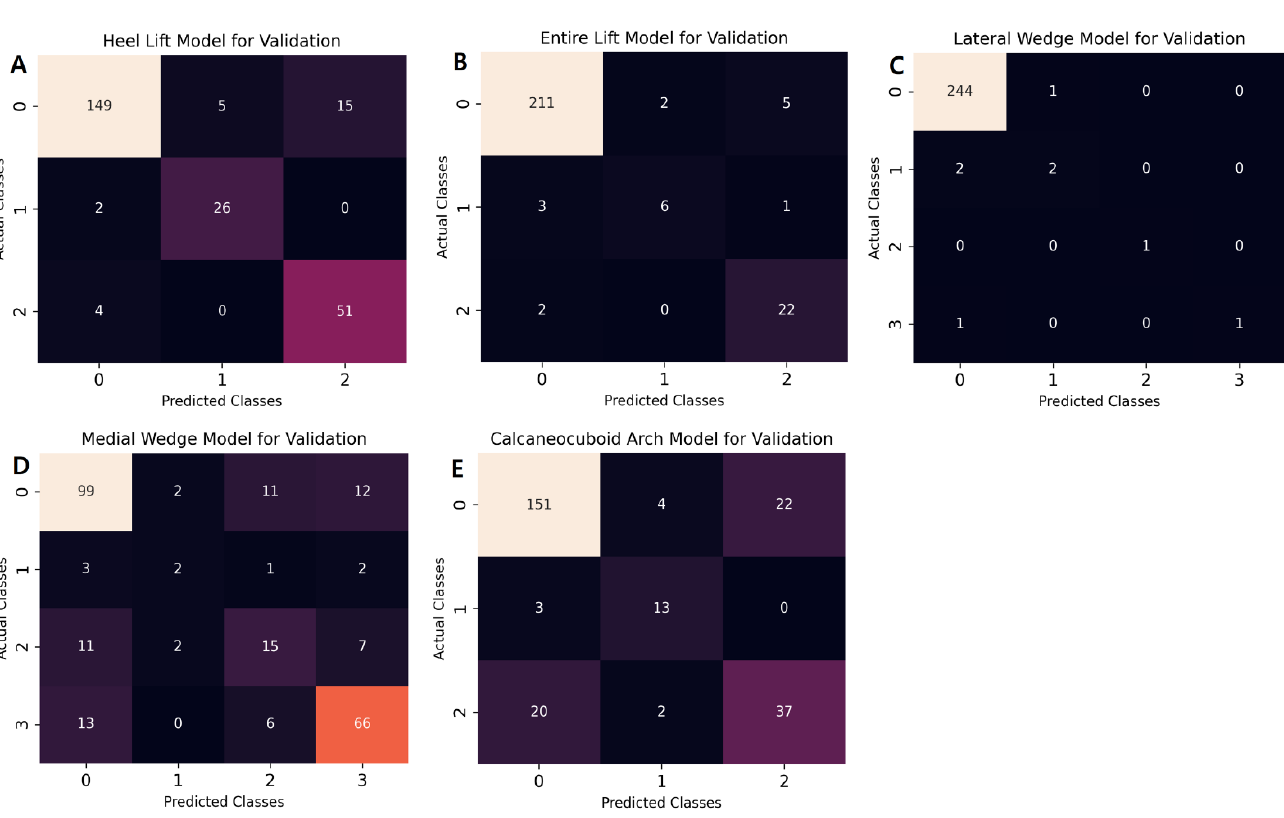
Figure 4. Confusion matrix of the deep-learning model for the prescription of orthotic insoles. ( A ) heel lift ( B ) entire lift ( C ) lateral wedge ( D ) medial wedge ( E ) calcaneocuboid arch.